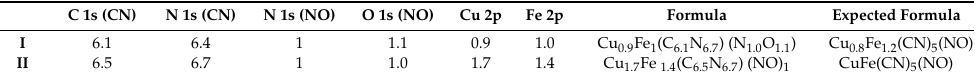
Table 2. XPS quantification (normalized areas) of sample I and II. The value of N (NO) was set to 1.